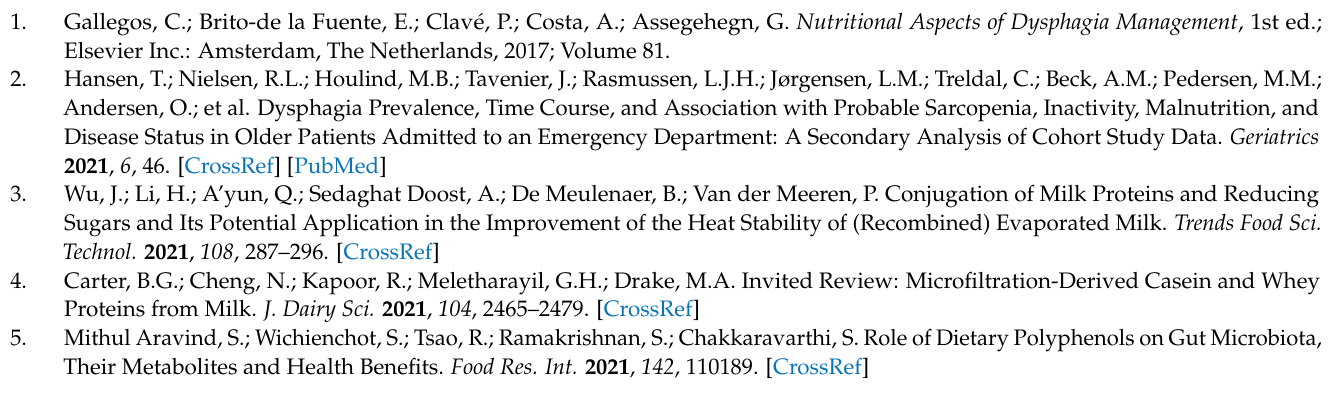
Table S1: Energy content and nutritional composition of 100 g of casein cocoa dessert containing casein. Table S2: IDDSI parameters and apparent viscosity at a 50 s- 1 shear rate for the untreated and treated protein